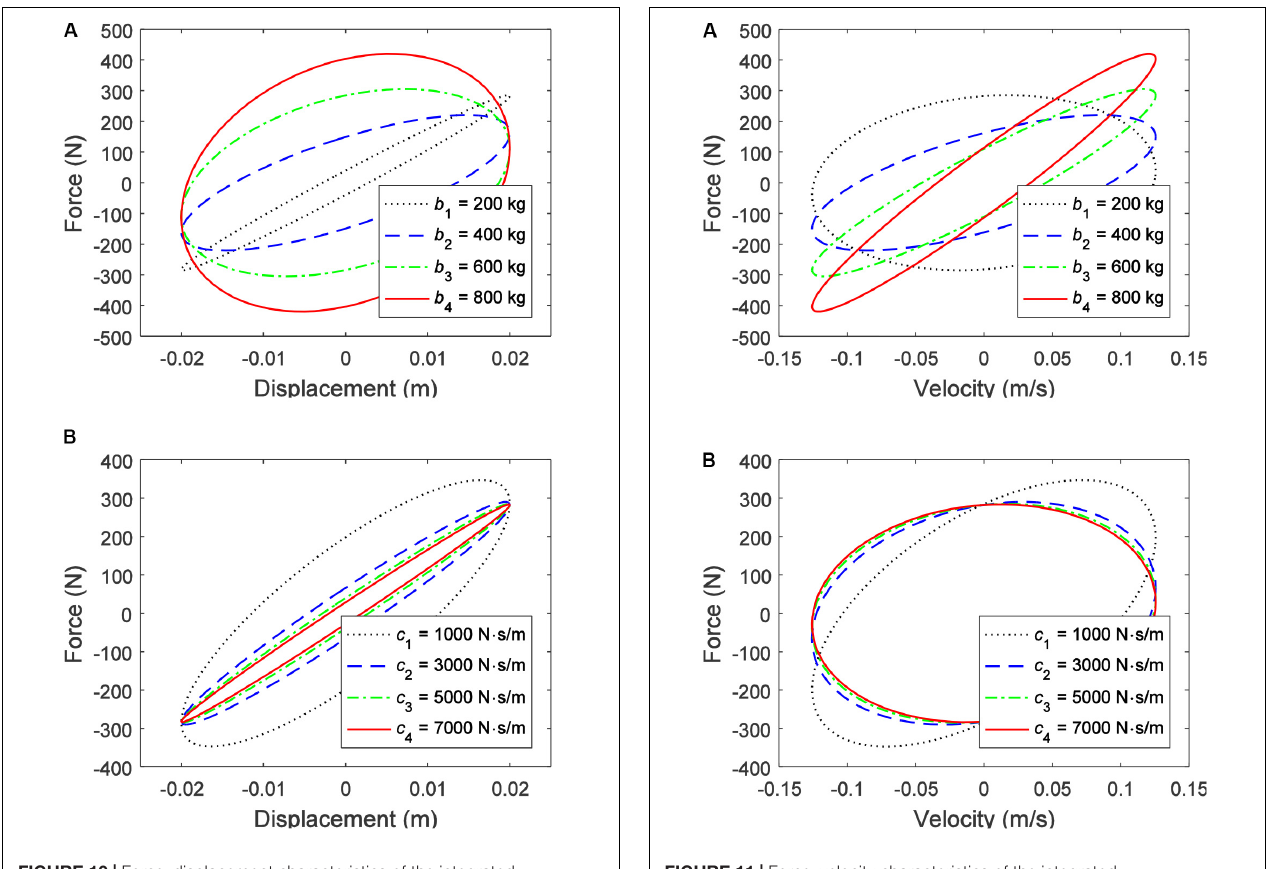
FIGURE 10 | Force–displacement characteristics of the integrated inerter-spring-damper: (A) different inertances and (B) different damping coefficients.